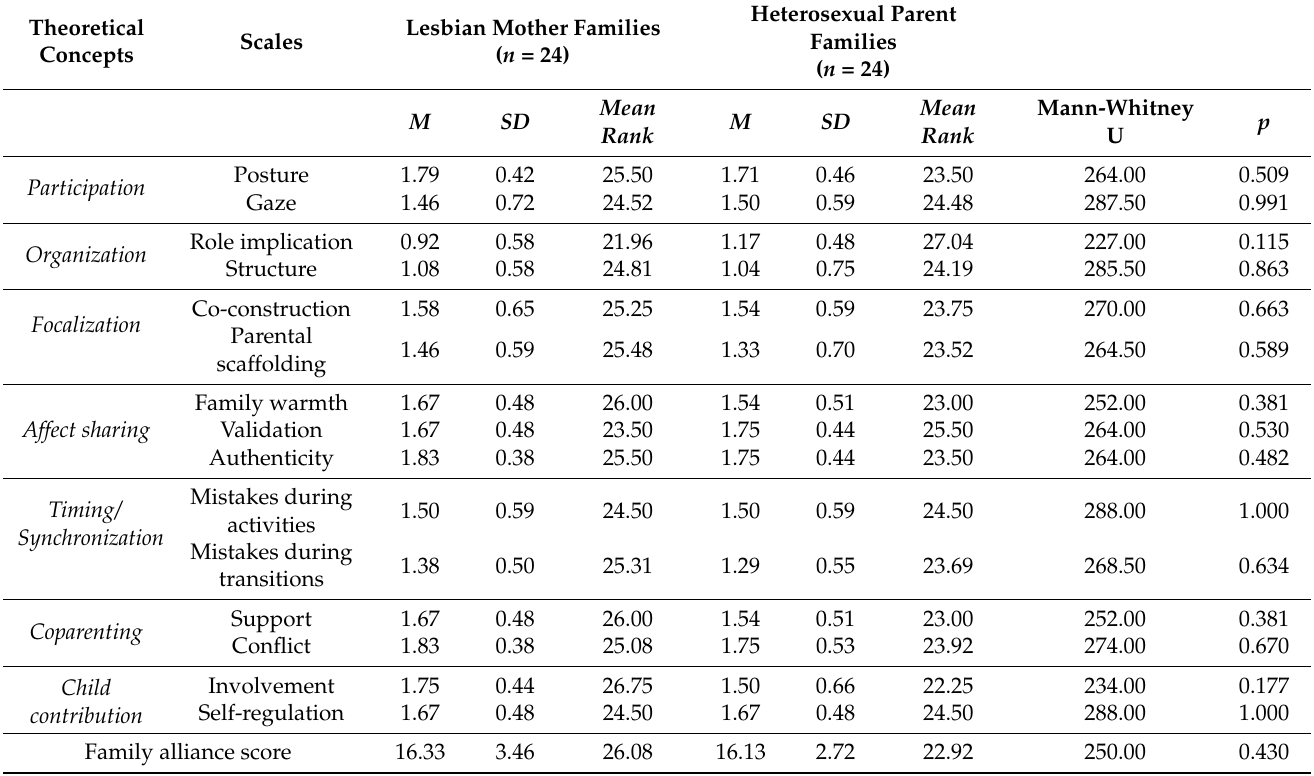
Table 1. Comparison of Family Alliance Assessment Scale scores between family groups (N =